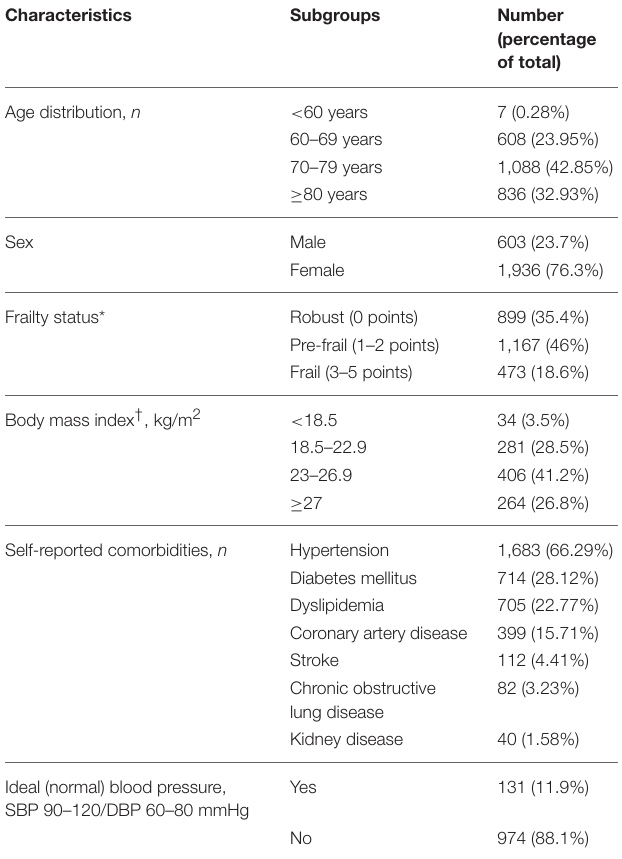
TABLE 2 | Interim analysis of characteristics and demographics of Hong Kong respondents ( n = 2,539) in the Wellbeing Survey via mobile device app.